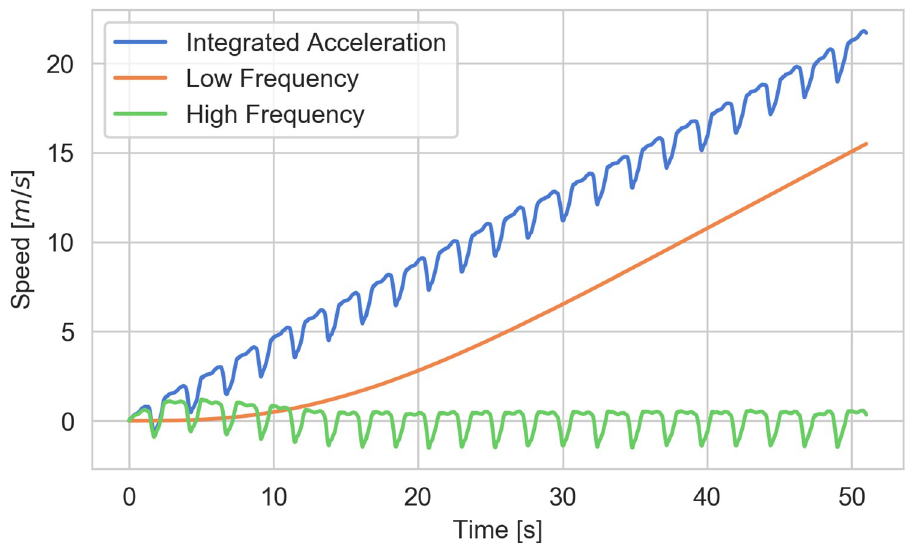
Fig 6. Example of low and high frequency components of speed derived from the integrated accelerometer measurement. The blue curve shows the effect of the accelerometer bias on the speed estimate. The approximately constant slope of this curve indicates that the accelerometer bias is also approximately constant. The orange and green curves show the measurement separated into low and high frequency components.